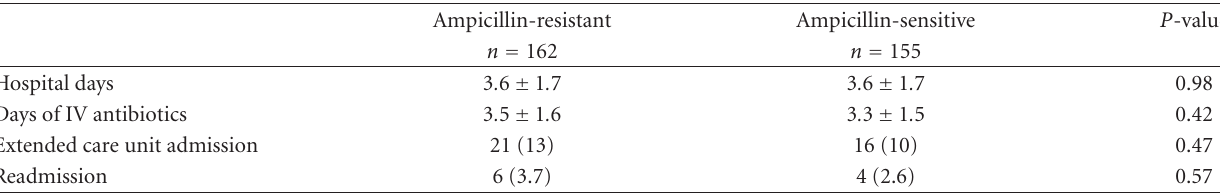
Table 4: Summary of hospital stay of women with ampicillin-resistant versus ampicillin-sensitive uropathogens in acute antepartum pyelonephritis . Data are reported as n (%) or mean ± standard